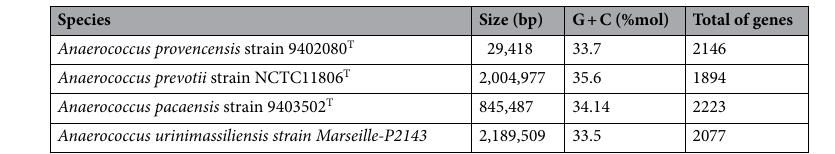
Table 4. Comparison of genome size, G + C mol% content and gene count of Marseille-P2143 T with other species within the family Peptoniphilaceae